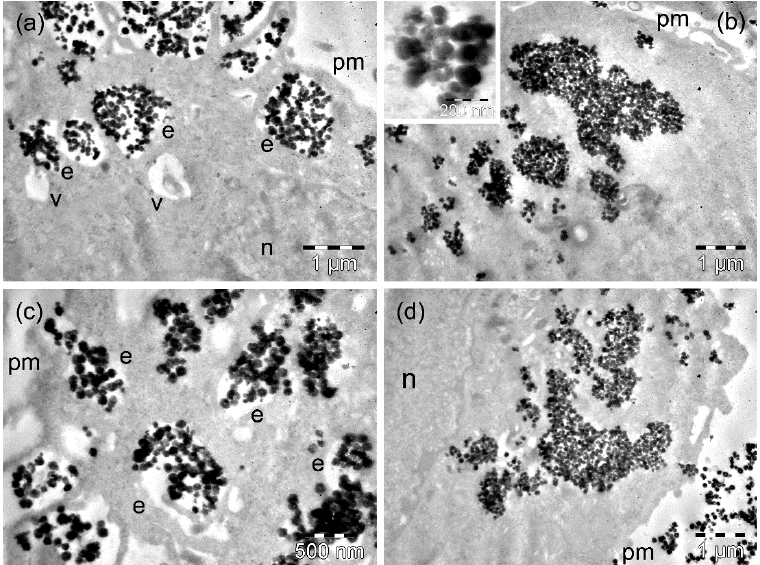
Figure 5. TEM images of D407 cells containing MnFe 2 O 4 MNPs after 4 h ( a , b ) and 24 h ( c , d ) of incubation time. The letters n, e, v, and pm denote the nucleus, the endosomes, the vacuoles, and the plasma membranes, respectively. The inset in (b) on the left shows the formation of an endosome with MnFe 2 O 4 MNPs.